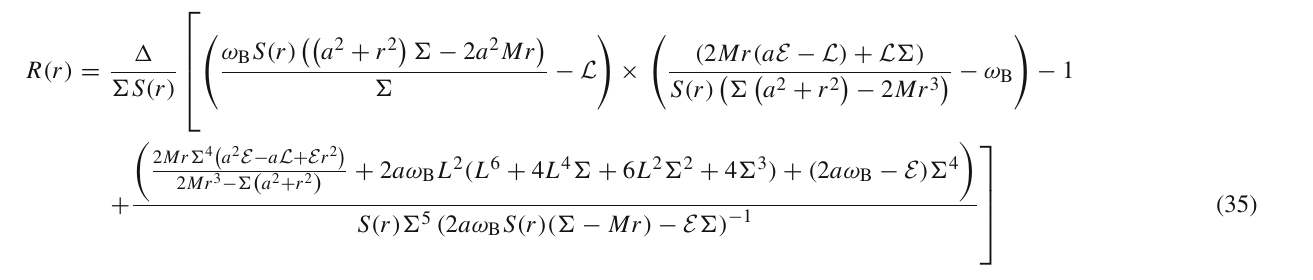
Fig. 10 Trajectories of positively charged particles around a non- rotating black hole immersed in a magnetic field in conformal grav- ity. Red, black and blue trajectories correspond to the case N = 1, 4, and 8, respectively, when the conformal parameter L / M = 1 started